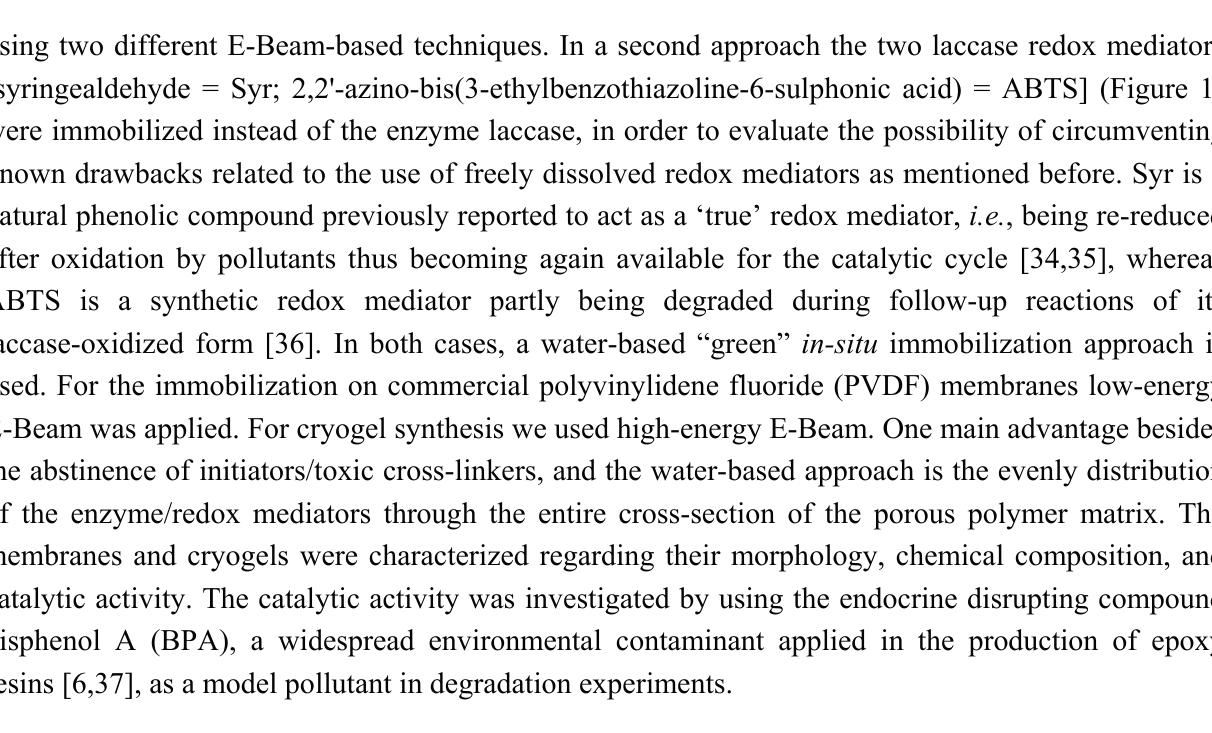
Figure 1. Chemical structures of the membrane polymer PVDF, and the redox mediators Syr and